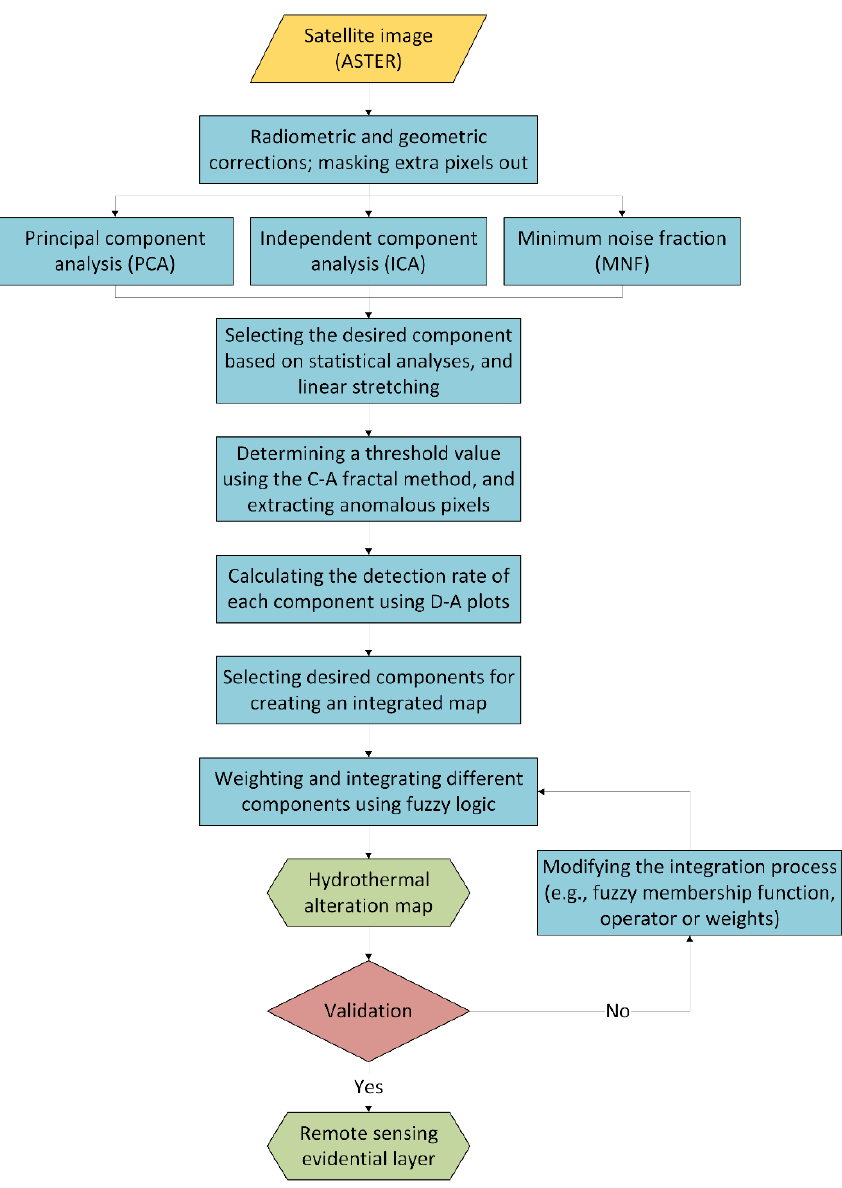
Figure 3. Methodology flowchart for generating a remote sensing evidential layer. We used ASTER remote sensing data as the input to this flowchart, which can be replaced with other types of satellite